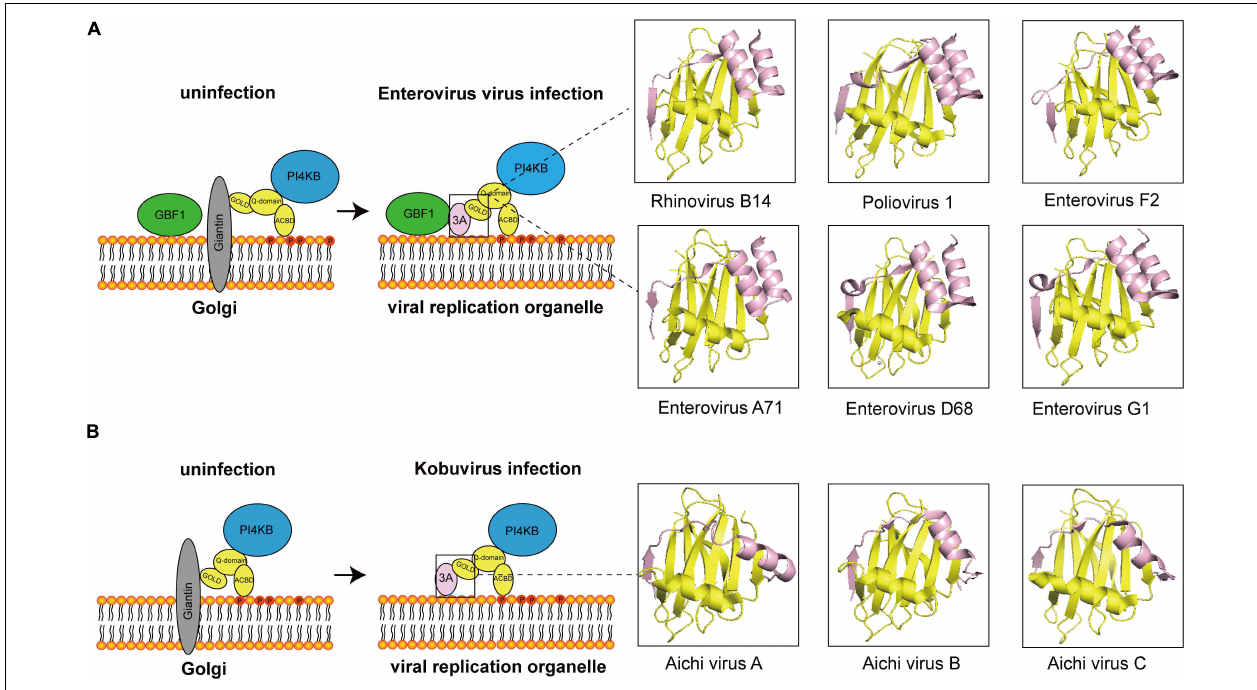
FIGURE 1 | The diagram of how 3A proteins from enterovirus and kobuvirus hijack ACBD3. (A) In uninfected cells, the GOLD domain of ACBD3 binds to giantin that is anchored to the Golgi membrane. GBF1 is localized in membrane. PI4KB is localized to the Golgi through interaction with the Q-domain of ACBD3. In enterovirus-infected cells, viral proteins 3A compete with giantin for binding to ACBD3. 3A also interacts with GBF1. The 3C/ACBD3/PI4KB complex is formed in viral ROs. The crystal structures of ACBD3 GOLD domain in complex with 3A protein from human Rhinovirus B14 (Protein Data Bank ID: 6HLT), human Poliovirus 1 (Protein Data Bank ID: 6HLV), bovine human Enterovirus F2 (Protein Data Bank ID: 6Q68), human Enterovirus A71 (Protein Data Bank ID: 6HLW), human Enterovirus D68 (Protein Data Bank ID: 6HLN), and porcine Enterovirus G1 (Protein Data Bank ID: 6Q69) were shown in the right. (B) In uninfected cells, the GOLD domain of ACBD3 binds to giantin that is anchored to the Golgi membrane. PI4KB is localized to the Golgi through interaction with the Q-domain of ACBD3. In Kobuvirus-infected cells, viral proteins 3A compete with giantin for binding to ACBD3. The 3C/ACBD3/PI4KB complex is formed in viral ROs. The crystal structures of ACBD3 GOLD domain in complex with 3A protein from human Aichi virus A (Protein Data Bank ID: 5LZ3), human Aichi virus B (Protein Data Bank ID: 5LZ6), porcine Aichi virus C (Protein Data Bank ID: 6Q67) were shown in the right.